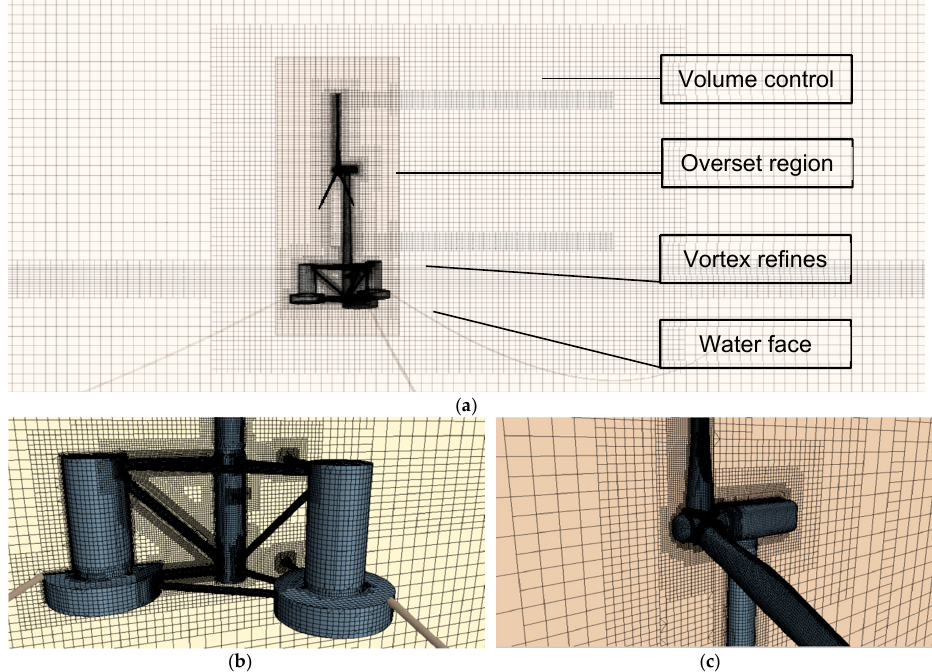
Figure 10. Full-coupled floating offshore wind turbines (FOWT) domain: ( a ) Mesh distribution in xz-plane; ( b ) Close-up view of mesh around platform; ( c ) Close-up view of mesh around wind turbine.